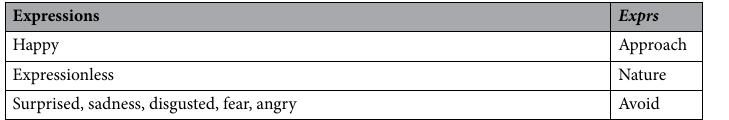
Table 2. Classification of human expression according to the correlation between expressions and human– robot interactive intentions.